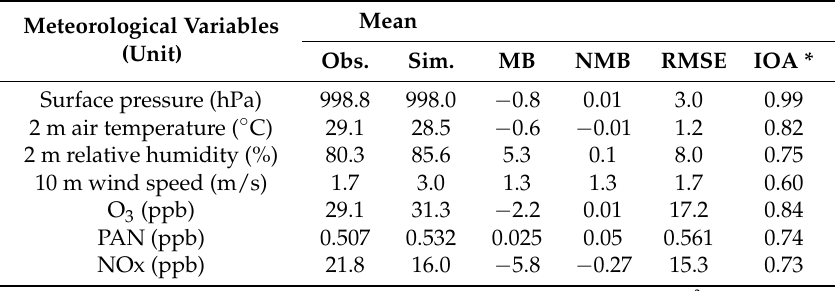
Figure 3. Temporal profiles of winds, temperature, O 3 , PAN, NO, and NO 2 measured (black) at the backgarden site during the study period, along with the simulated values (red) from CMAQ (no observed data were recorded on 22 July due to power outrage). Table 2. Comparison of modeling results with